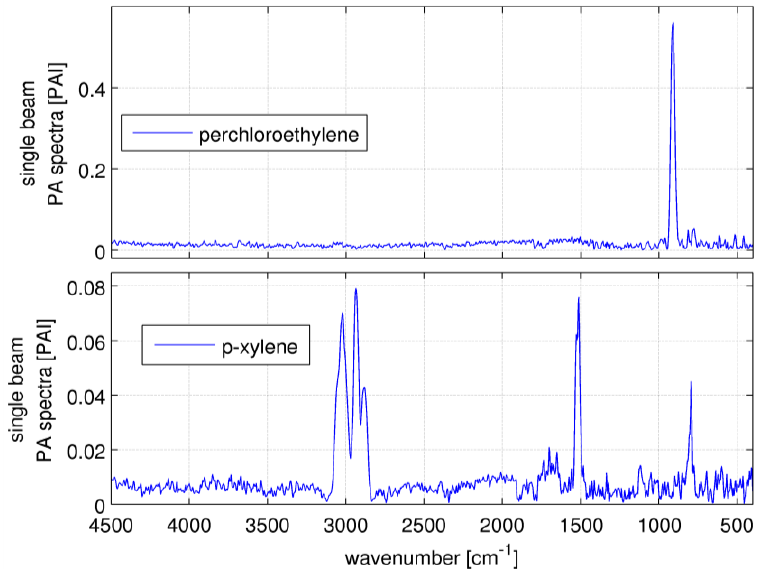
Figure 4. Two extreme cases for multivariate data analysis: spectra of perchloroethylene (PCE) and p -xylene. Perchloroethylene shows one fine absorption band, which does not gain that much from multivariate data analysis. Vice versa , p -xylene gains from multivariate analysis, because its spectrum has tiny but several absorption bands, from which one is relatively broad.